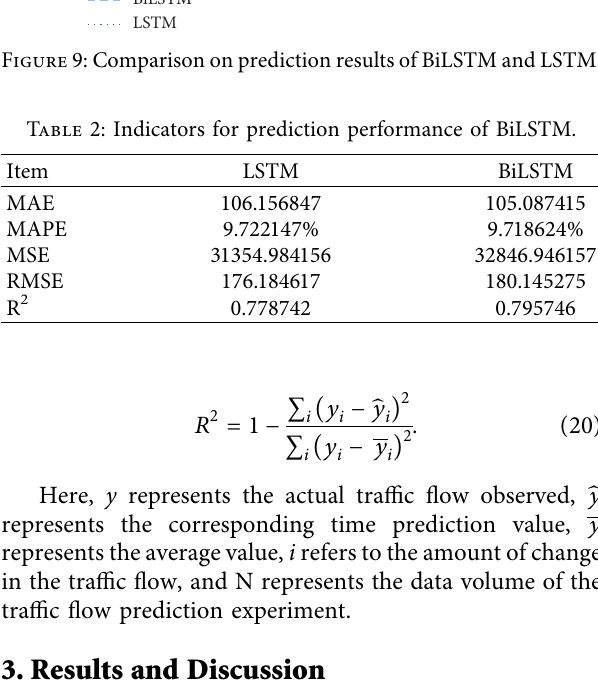
Figure 7: Predicted results of LSTM.